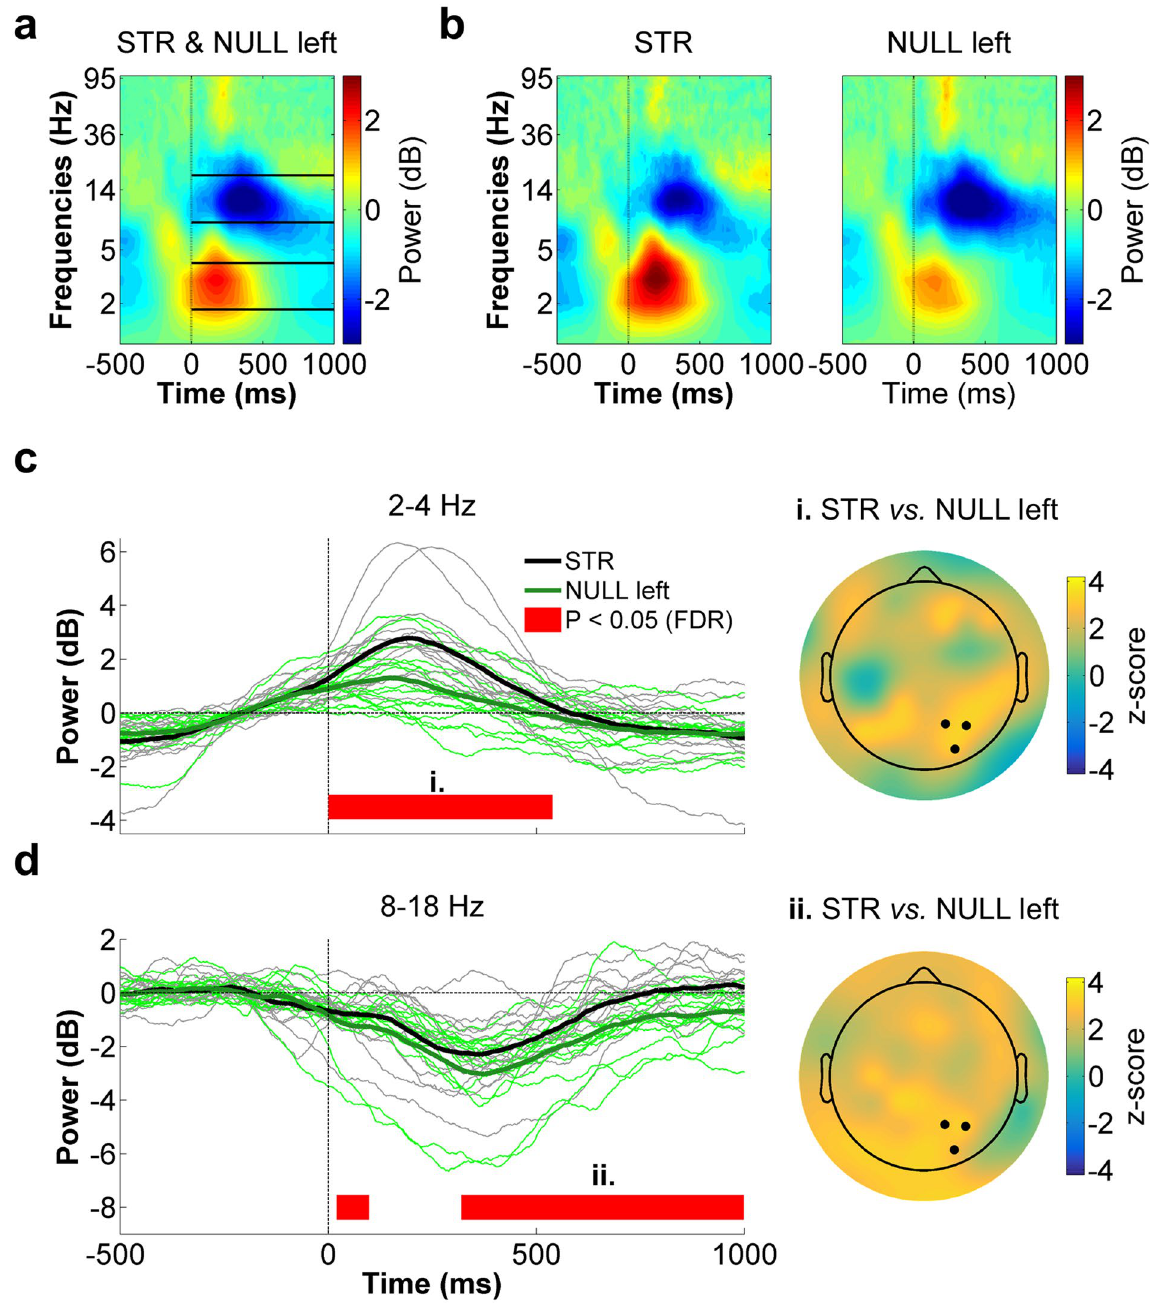
Figure 6. Right parietal ROI time-frequency data for STR vs . NULL left. ( a ) Spectrogram representing the mean ERSPs for STR and NULL left. The solid lines delimit the frequency bands selected for statistical analyses ( i.e . 2–4 Hz and 8–18 Hz). Time “0 ms” corresponds to movement onset. ( b ) STR (left panel) and NULL left (right panel) ERSPs. ( c ) Low theta (2–4 Hz) spectral power time-course for STR (black) and NULL left (green) (left panel). The scalp map (right panel) represents the statistical z-scores across electrodes for low theta power differences between STR and NULL left during the significant time window (i. 0–520 ms). ( d ) Alpha/low beta (8–18 Hz) spectral power time-course for STR (black) and NULL left (green) (left panel). The scalp map (right panel) represents the statistical z-scores across electrodes for alpha/low beta power differences between STR and NULL left during the significant time window (ii. 360–1000 ms). In the left panels of both ( c ) and ( d ), the thin waveforms represent individual participant data, the thick waveforms represent the mean power across participants and the red line highlights the time bins showing statistically significant differences between STR and NULL left ( p ≤ 0.05, FDR-corrected). In the right panels of both ( c ) and ( d ), the highlighted electrodes denote those that make up the right parietal ROI (P2, P4 and